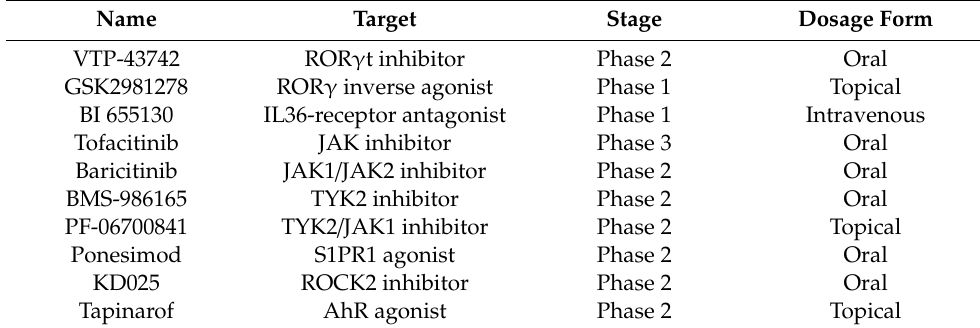
Figure 2. Summary of new treatment. ( a ) JAK inhibitor blocks the JAK-STAT signal pathway in Th17 cells. ( b ) Ponesimod, a selective S1P1 agonist, induces sequestration of lymphocytes into lymph nodes and decreases peripheral lymphocyte counts and trafficking of lymphocytes to peripheral tissues. ( c ) KD025, ROCK2 inhibitor reduces IL17 secretion in Th17 cells. ( d ) Tapinarof, AhR agonist reduces IL17 and IL22 in Th17 cells. JAK: Janus kinase; STAT: signal transducer and activator of transcription; S1PR1: sphingosine-1-phosphate receptor 1; ROCK2: Rho-associated kinase 2; IL: interleukin; AhR: aryl hydrocarbon receptor. Table 2. Summary of new treatments under clinical trials for